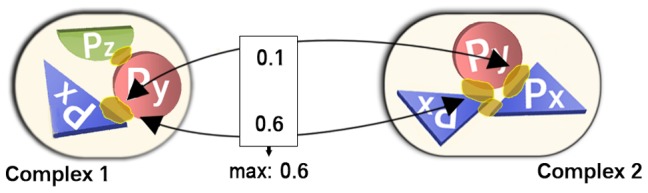
Filtering out interface diversity introduced by homomers.Assume you want to compare an interface Px-Py in complex 1 to the interfaces in complex 2. Usually, you will calculate two similarities (0.1 and 0.6), because there are two Px-Py interfaces in complex 2. Looking for homomers, you will find the two sequence identical Px chains in complex 2 interacting and connecting the two Px-Py interfaces. Now, you can correct the comparison by using only the one best match (0.6). The comparisons of the “worse” alternatives are discarded.